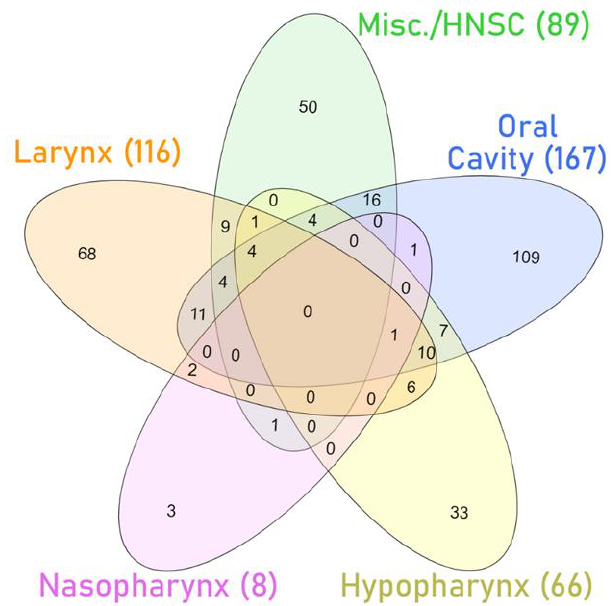
Figure 4. Venn diagram with the number of microRNAs differentially expressed (upregulated and downregulated) between tumors and nontumor tissues in several studies with specific subsets of HNSCC (larynx [241–244], nasopharynx [245], hypopharynx [246,247], and oral cavity [248–251]) or aggregating several sites in the analysis (Misc./HNSCC) [252–254]. The list of differentially expressed microRNAs can be found in Table